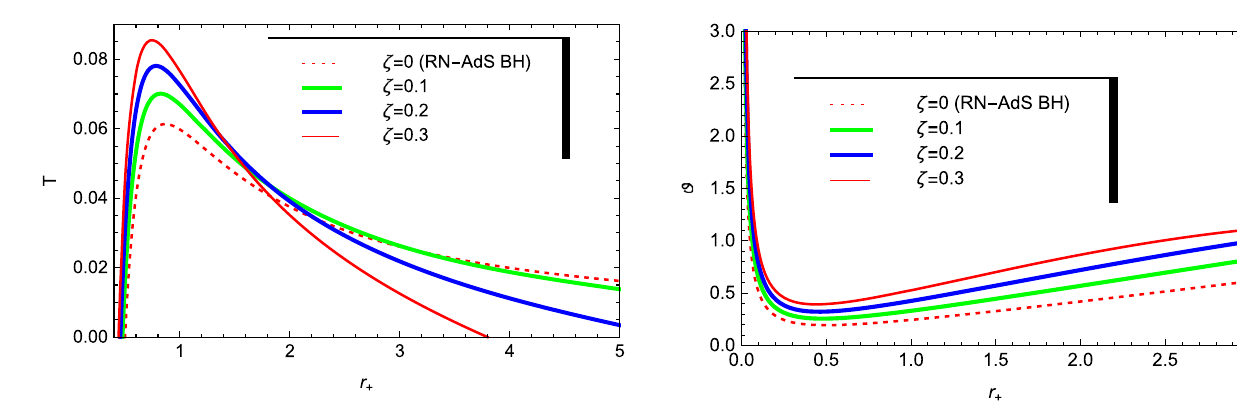
4 π Fig. 7 Plot of deflection angle w.r.t r + for increasing values of the coupling constant. We use Q = 1, b = 10, l 2 = 675 4